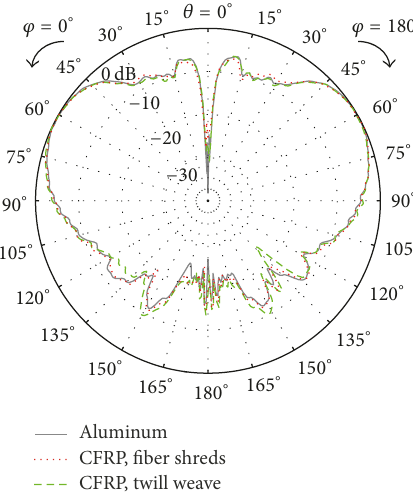
Figure 10: Monopole antenna for 5.9 GHz on a circular ground plane. Vertical cut of the normalized measured gain pattern for azimuth 𝜑 = 0 ∘ (reprinted with permission from [34]; ©2014 IEEE).